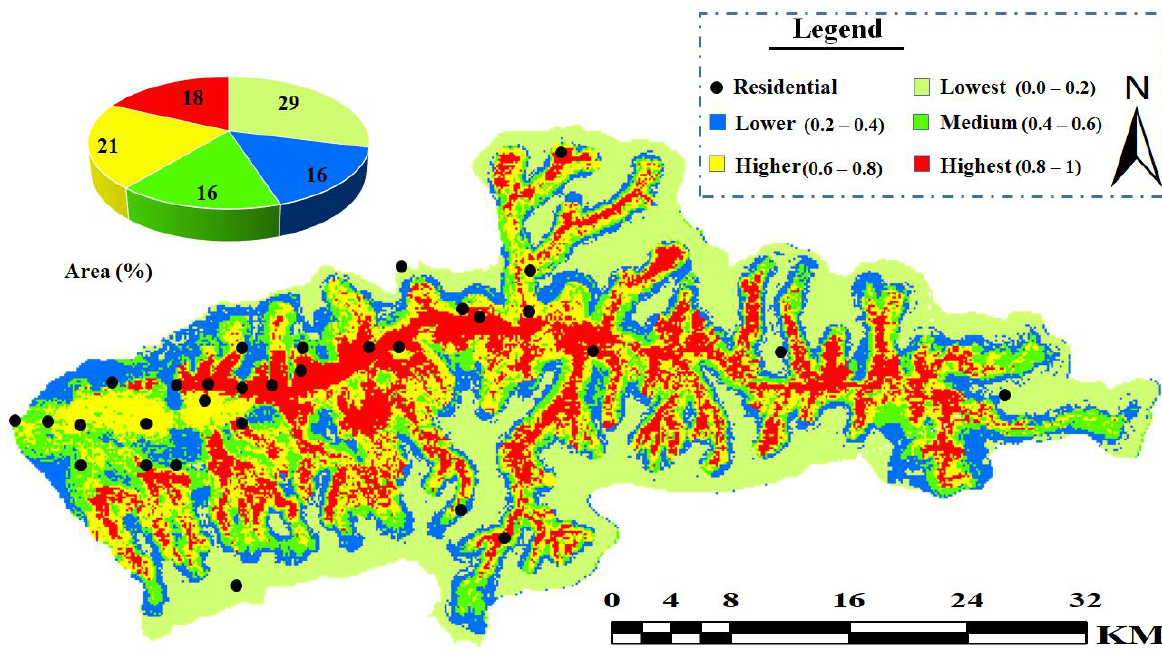
Figure 6. Map of flood risk assessment by the RF model.